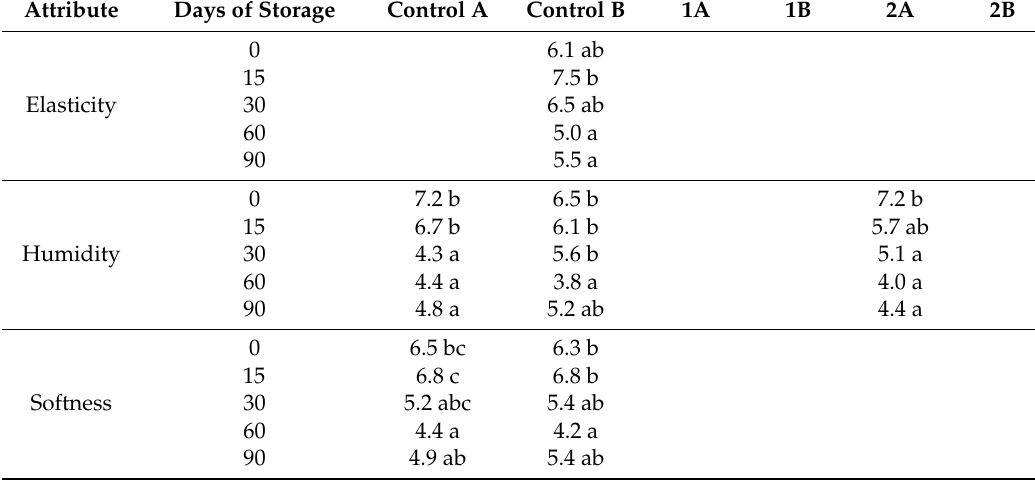
Table 10. Mean values of the significantly di ff erent sensory attributes (comparison during storage). Three bread loaves were collected at each